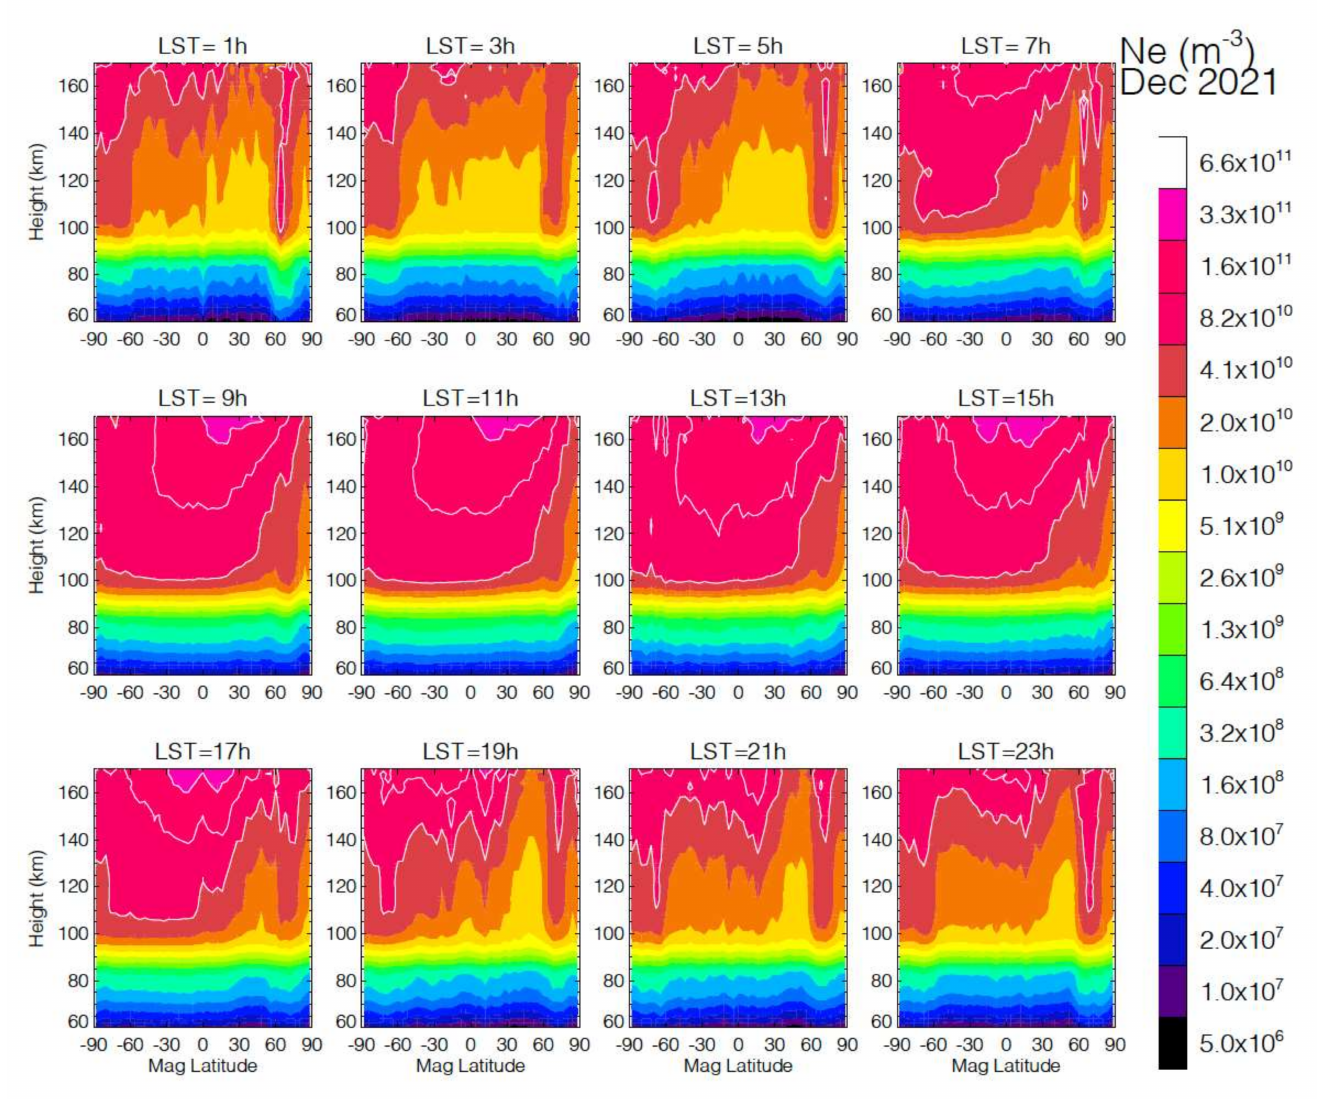
Figure 12. E - to F -region transition in N e for December 2021 from the Spire constellation. The Spire receivers acquire GNSS-RO routinely with a top up to ~175 km, allowing the N e retrieval to be extended to the F1